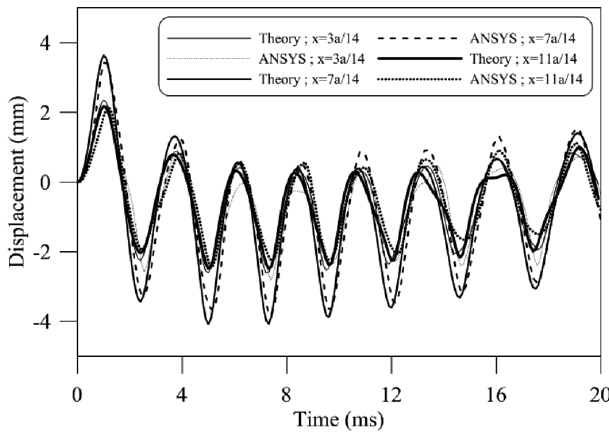
Fig. 17. The displacement-time histories of the simply-supported tapered laminated plates ( β = 1.2) with [0/0/0] S for the stacking sequence [BCUCBG] S